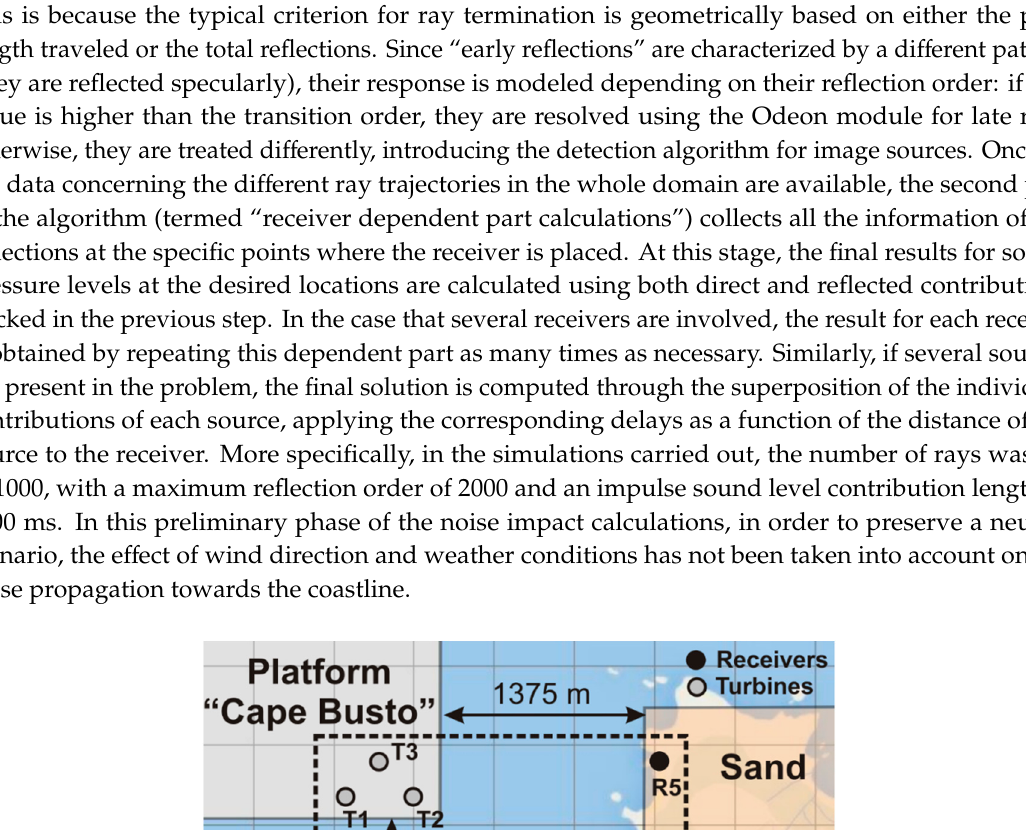
Figure 5. Sources and receivers’ positions for the Llumeres location. The location of the sources is a very important issue because a wind turbine that is placed in the wake of another may produce less power due to the aerodynamic shadow of the upstream turbine. On the other hand, having relatively small distances between turbines allows installing a larger number of turbines but reduces the power rated by each in the wind farm. Aerodynamic losses can be reduced by optimizing the geometry of the wind farm, since the wake may have different effects depending on the size of the turbines and spacing distribution within the park. In a wind farm, the minimum spacing between turbines (sources) is 5–9 times the diameter of the rotor in the direction of the prevailing wind and 3–5 times the diameter of the rotor in the direction perpendicular to the prevailing wind. Additionally, when the wind has frequent changes of direction with respect to the prevailing speed, the turbines should be placed in a staggered distribution [23]. Figures 4 and 5 show in detail the arrangement of the sources (wind turbines) and the considered receivers (five in total) in the two offshore platforms. Corresponding coordinates are given in Tables 2 and 3. The dashed lines enclose the domain considered for simulation. The turbine positions were established depending on the available geometry in the corresponding offshore platform. In both locations, Cape Busto and Llumeres, the maximum number of allowed wind turbines running